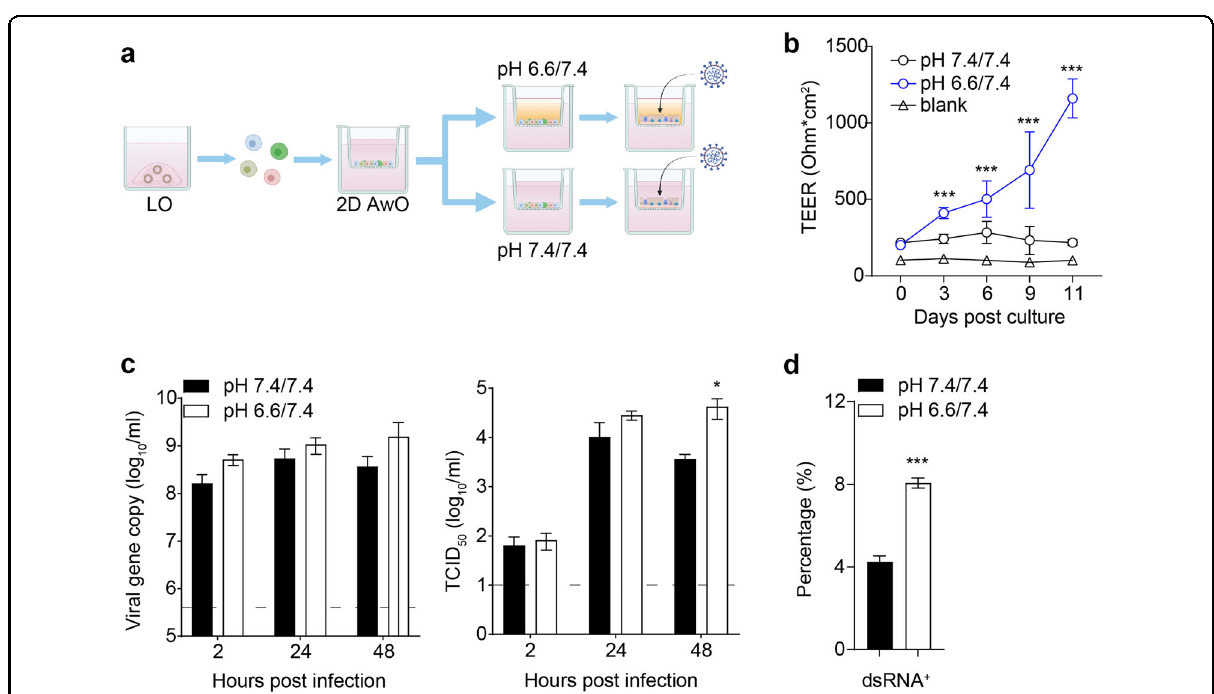
Fig. 5 Enhanced SARS-CoV-2 replication in optimized 2D airway organoids. a A schematic graph outlines the optimization of 2D airway organoids for modeling SARS-CoV-2 infection. b 2D airway organoids incubated with the differentiation medium of pH 6.6/7.4 or 7.4/7.4 were measured for trans-epithelial electrical resistance (TEER) at the indicated days. Data represent means ± SD of a representative experiment, n = 9. Two- tailed unpaired Student ’ s t -test. c At the indicated hours post-infection with WT SARS-CoV-2 (MOI = 0.1), culture media were harvested from the apical chambers of the 2D airway organoids and applied to viral load detection and viral titration by TCID 50 assay. Data show means ± SD of a representative experiment, n = 3. Two-tailed unpaired Student ’ s t -test. d At 24 hpi, cells were harvested from 2D airway organoids infected with SARS-CoV-2 (MOI = 10) and applied to fl ow cytometry to detect dsRNA + virus-infected cells. Data represent means ± SD of a representative experiment, n = 3. Two-tailed unpaired Student ’ s t -test. See also Supplementary Fig.